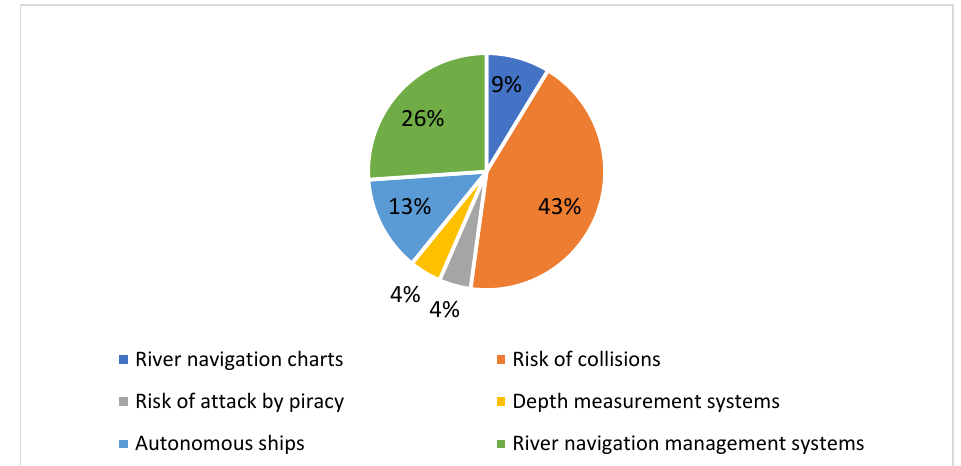
Figure 6. Smart navigation subdomains.